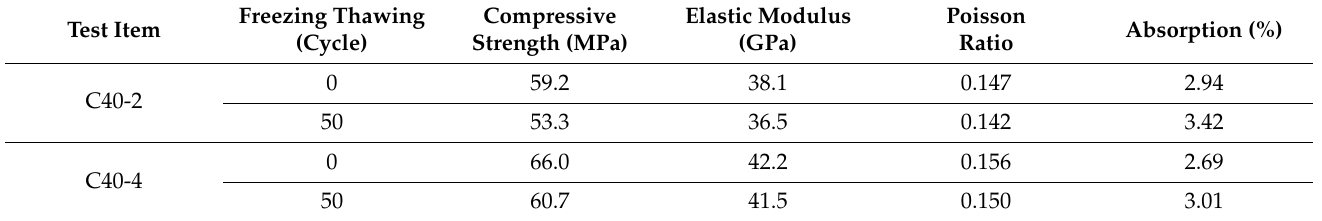
Table 14. Test results of compressive strength, elastic modulus, poisson ratio and absorption.